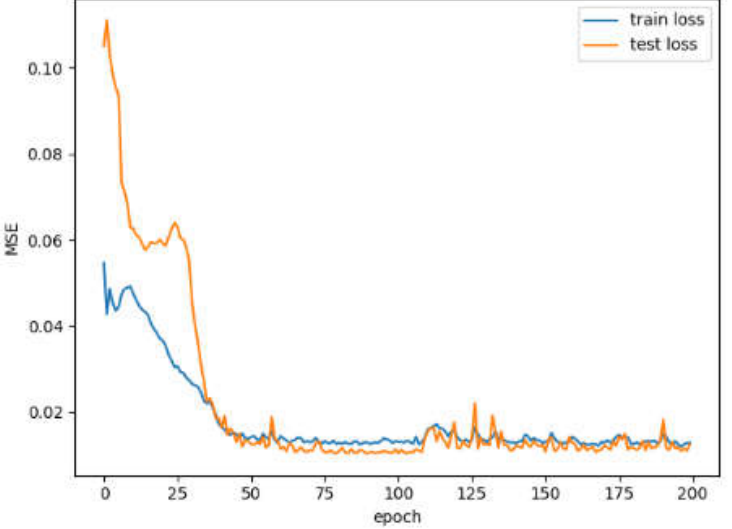
Figure 4. Parameter epoch adjustment experiment. The X-axis represents the value of epoch , and the Y-axis represents the mean square error.